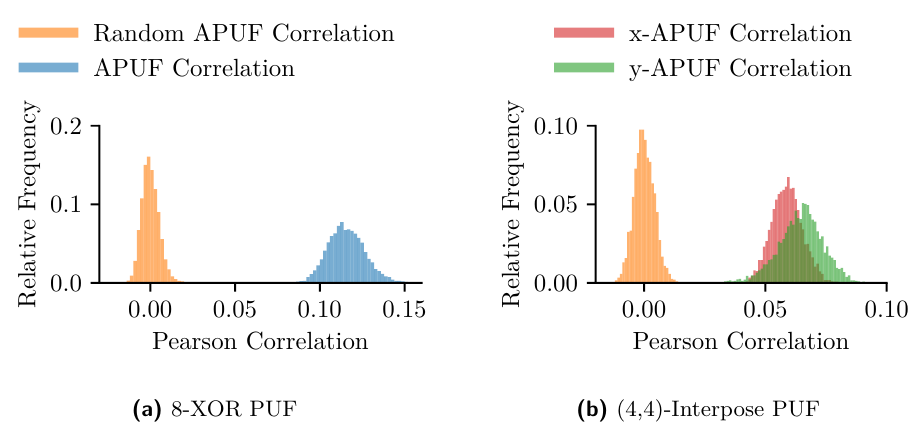
Figure 2: Simulated correlations between 8-XOR PUFs and (4,4)-iPUFs reliability and the reliability to their individual APUF reliabilities (1000 PUF instances per type). Additional, the correlation to random APUF instances is given. Both PUFs use APUFs with 64 stages and a mean APUF accuracy of 0 . 97. The correlations were computed for 100 , 000 challenge-reliability